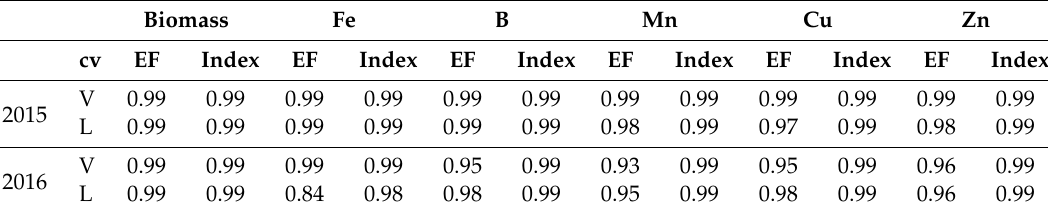
value of 1 represents a perfect fit between the simulated and the actual data [44].